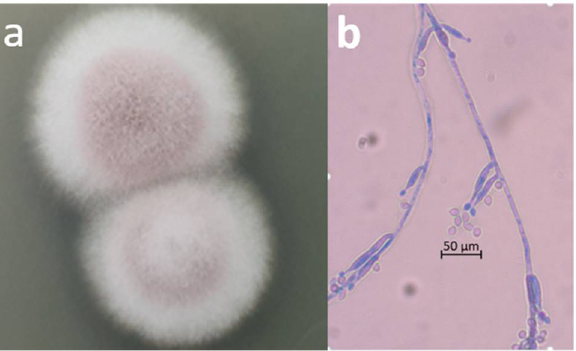
Figure 2. Colony of isolated fungus P. lilacinum 1925-1 on PDA ( a ) and conidiophores bearing ellipsoid conidia at 1000× magnification ( b ).